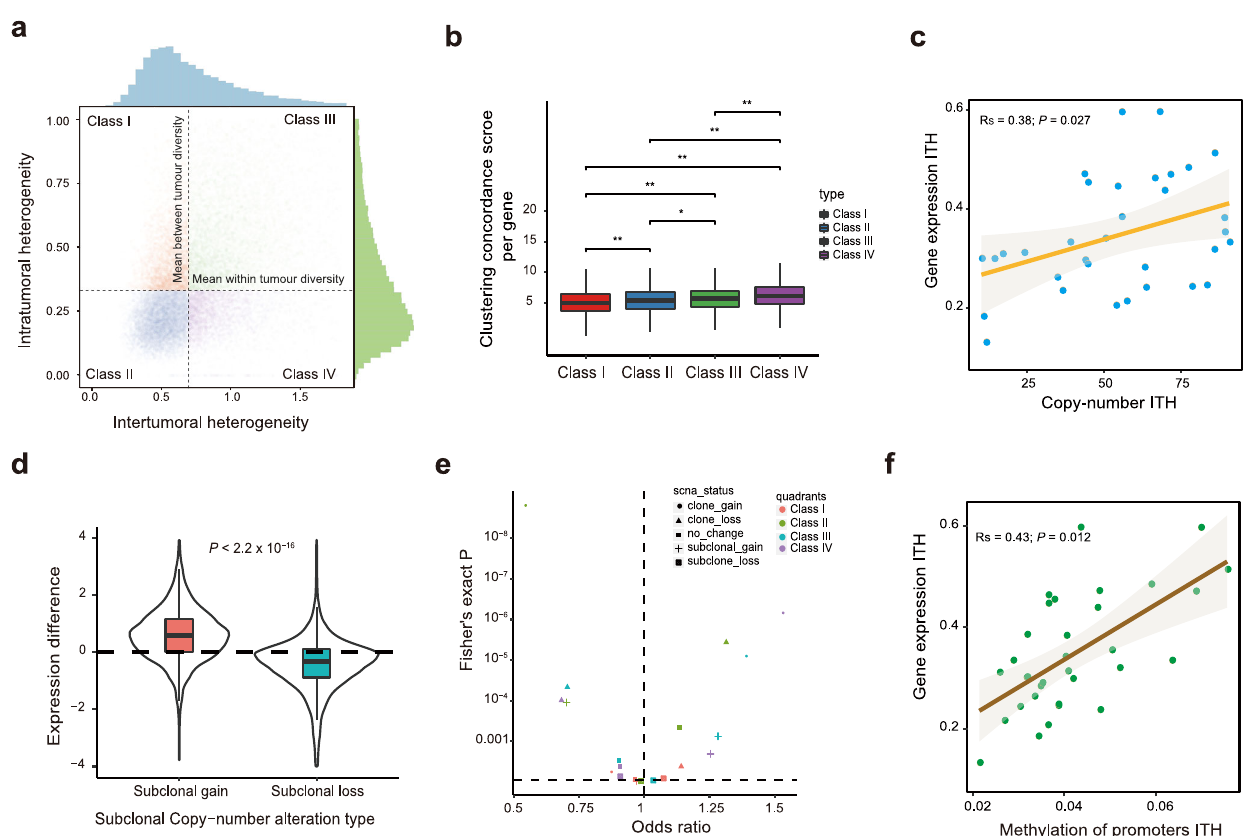
Fig. 3 | Fuels of transcriptomic ITH in ESCC. a RNA intertumor (x-axis) and RNA intratumor heterogeneity (y-axis) are shown on the axes using density curves. The genes are split into four classes by the mean intratumor and intertumor hetero- geneity scores. The classes are numbered and colored. b Boxplots show the clus- tering concordance score per gene in each class (I=3354 genes, II=11622 genes, III=5368genes,IV=3668genes).Theminimumandmaximumareindicatedbythe extremes of the box plot; the median is indicated by the thick horizontal line; and the fi rst and third quartiles are indicated by box edges; * P <0.05, ** P <0.01, two- sided Wilcoxon rank-sum test. c Correlation of gene expression ITH with copy- number ITH. The Spearman correlation coef fi cient (Rs) betweenpatient-wiseRNA- ITHscores and patient-wise SCNA-ITHscores calculated inthe ESCC cohort( n =33 ESCC patients; Rs = 0.38; P =0.027). Line of best fi t shown in orange and gray area